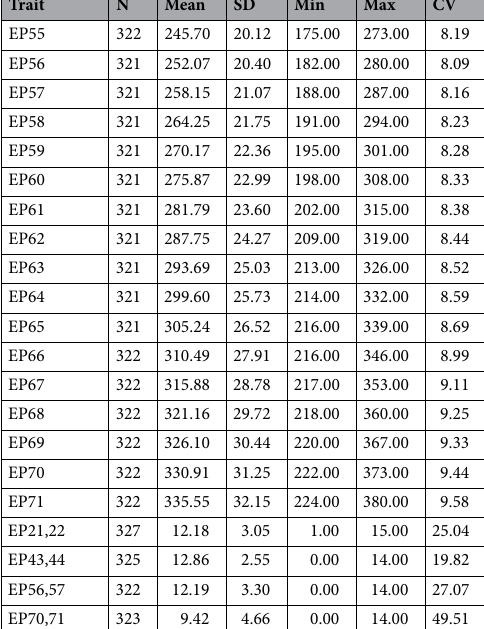
Table 4. The descriptive statistics of body weight, egg production and egg weight traits. BW0, BW17, BW43 and BW72, body weight at birth date, 17, 43 and 72 weeks; EW20, EW26, EW32, EW38, EW41, EW44, EW50, EW56, EW59, EW65 and EW68, egg weight at 20, 26, 32, 38, 41, 44, 50, 56, 59, 65, 68 weeks; EW71EN17 ~ EN71, egg production at 17–71 weeks; EN21,22, EN43,44, EN56,57 and EN70,71, egg production at 21–22, 43–44, 56–57, 70–71 weeks. SD standard deviation, CV coefficient of